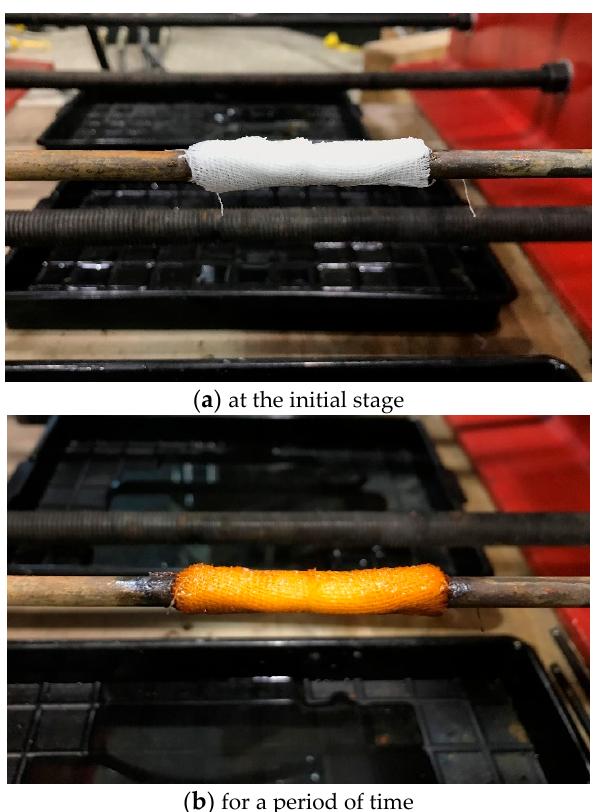
Figure 12. Morphology of steel wire.